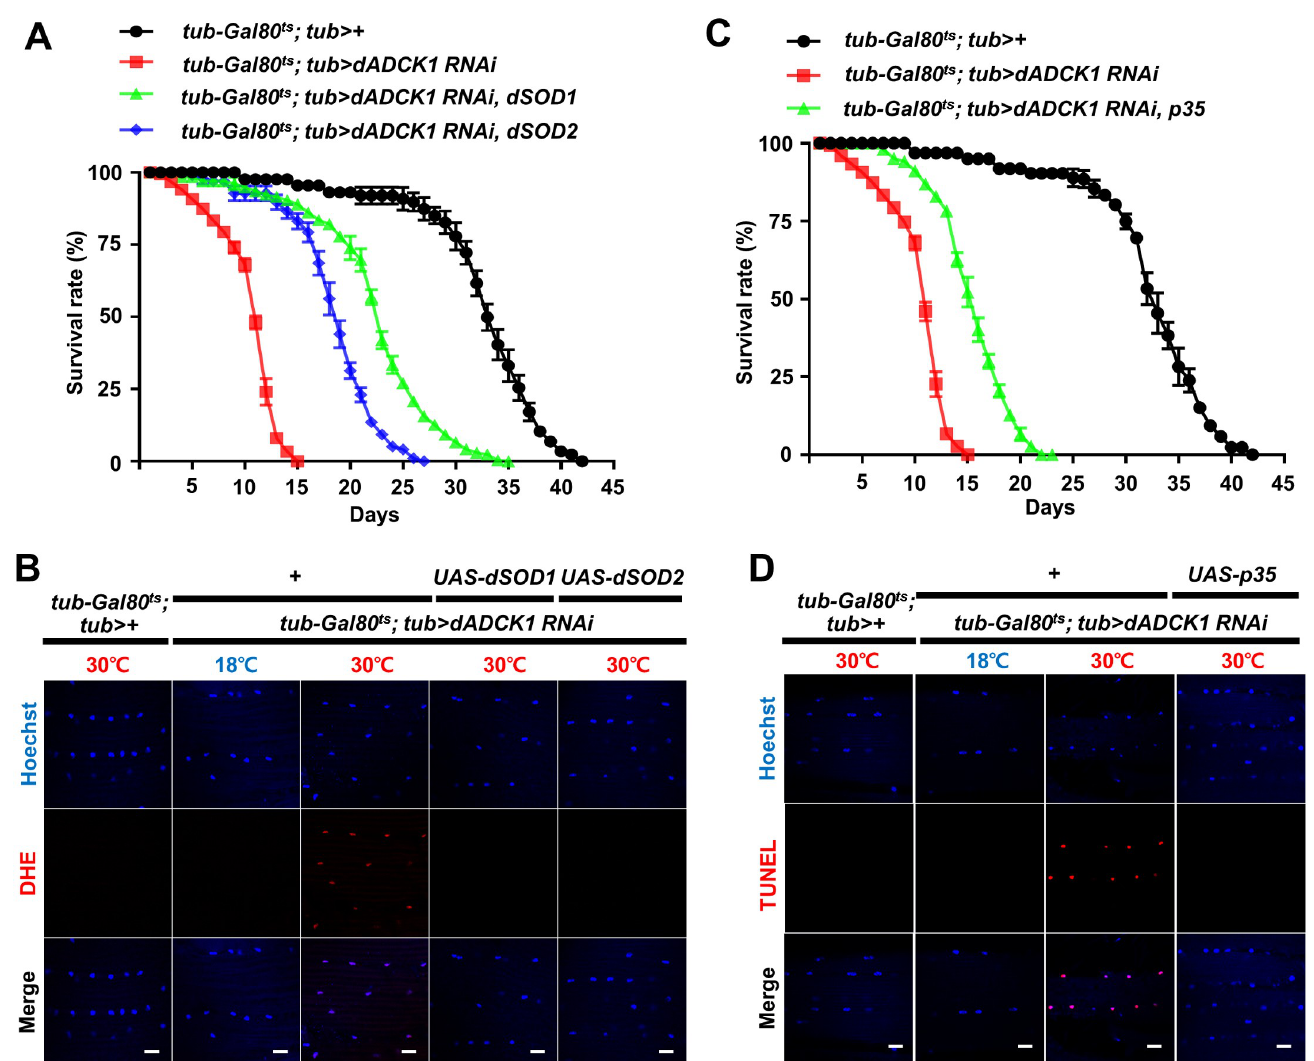
Fig 4. ADCK1 knockdown increases ROS level and apoptosis. (A) Comparison of the survival rate for the flies with indicated genotypes. n = 80. Statistical significance was analyzed by log-rank (Mantel-Cox) test. p < 0.0001. (B) Fluorescent confocal microscopy images of the adult fly thoraces with indicated genotypes and raised temperatures. Hoechst (blue) was used to mark the nuclei and DHE staining (red) was used to measure ROS level. Scale bars, 5 μ m. (C) Comparison of the survival rate of the flies with indicated genotypes. n = 60. Statistical significance was analyzed by log-rank (Mantel-Cox) test. p < 0.0001. (D) Fluorescent confocal microscopy images of the adult fly thoraces with indicated genotypes and raised temperatures. Hoechst (blue) was used to mark the nuclei and TUNEL staining (red) was used to detect apoptosis. Scale bars, 5 μ